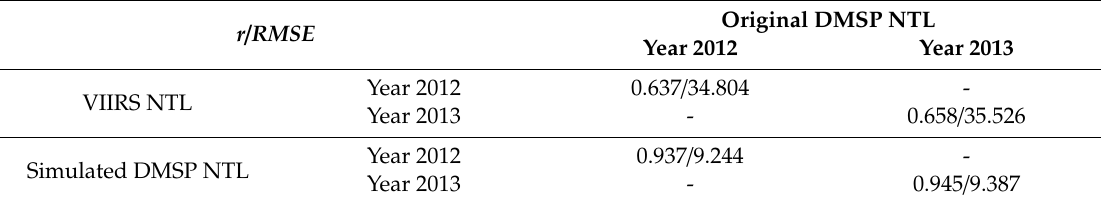
Table 3. Correlation between VIIRS and DMSP NTL in 2012 and 2013